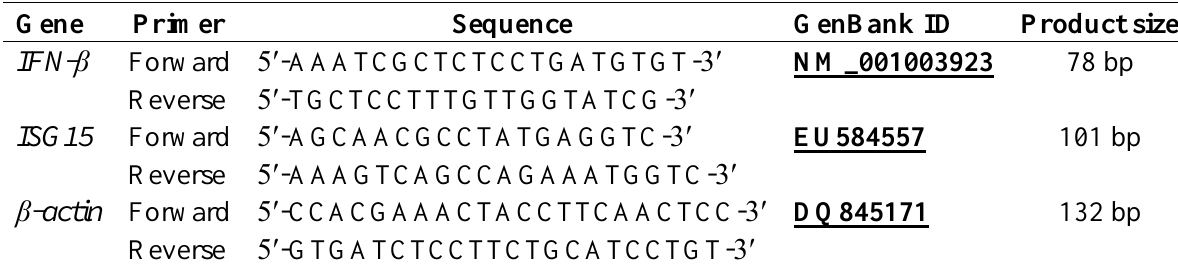
Table 1. Primers used in real-time quantitative